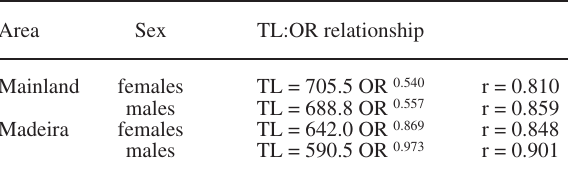
Table 6. – Relationships between the total length (tl) and the oto- lith radius (oR) in the females and males of Aphanopus carbo from mainland Portugal and Madeira.